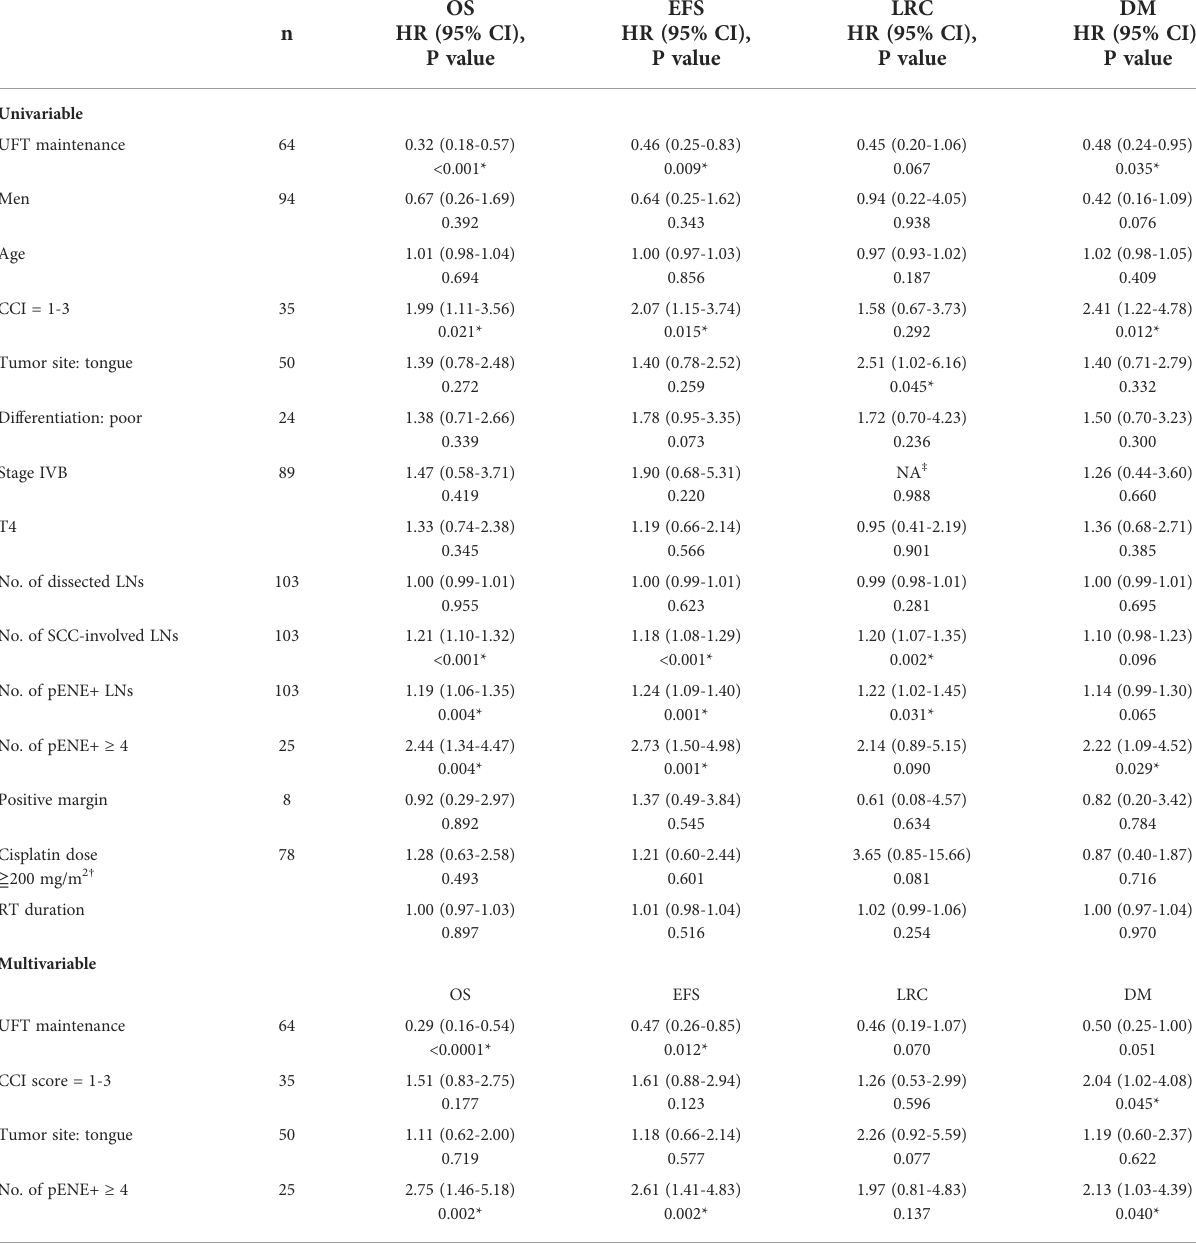
TABLE 3 Univariable and multivariable analyses (n =